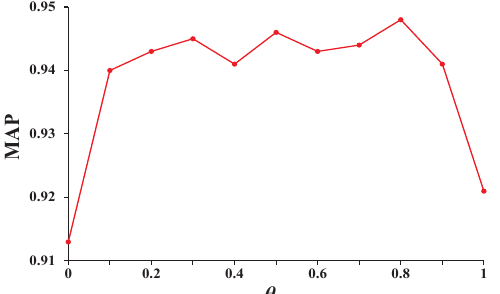
Figure 3. MAP performance of MST-RNN with varying parameter θ